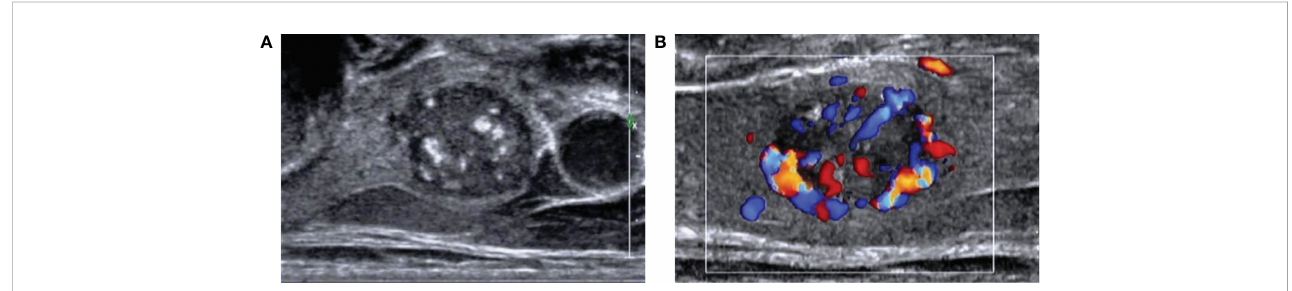
FIGURE 2 Images of a 55-year-old man with medullary thyroid carcinoma (MTC) (A) Ultrasound image showed a solid hypoechoic nodule with a clear boundary and lobulated margin. The aspect ratio was <1, and coarse calci fi cation could be seen in the nodule. (B) Color Doppler fl ow imaging showed abundant blood fl ow around and inside the